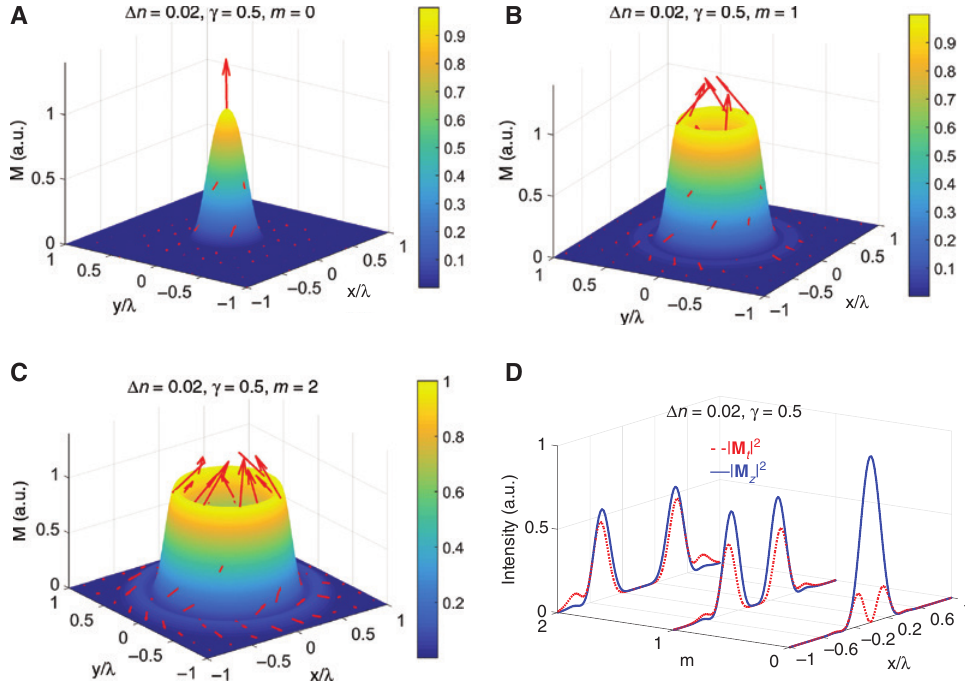
Figure 3: Magnetization pattern influenced by topological charge in a medium with a larger optical anisotropy than that shown in Figure 2. (Color online) Plots of optically induced magnetization in a medium of Δ n = 0.02 and γ = 0.5 with topological charge of (A) m = 0, (B) m = 1, and (C) m = 2. (D) Cross-section of the transverse and longitudinal components for the cases of m = 0, m = 1, and m =